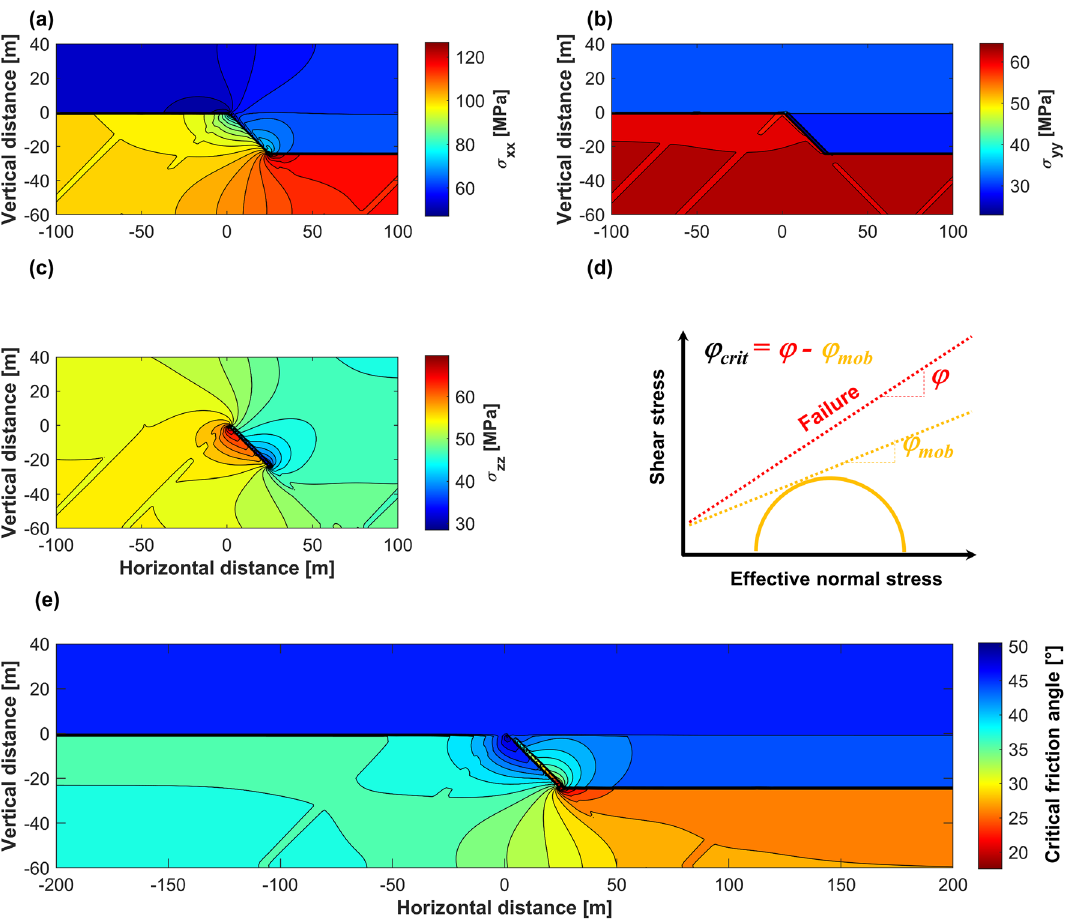
Figure 6. Stress state in the vicinity of the contact surface between competent and compliant layers. Contour lines of ( a ) horizontal in-plane total stress— σ xx , ( b ) horizontal out-of-plane total stress— σ yy , and ( c ) vertical total stress— σ zz . ( d ) Calculation of mobilized friction. ( e ) Proximity to failure in terms of the critical friction angle φ crit (difference between the friction angle φ and mobilized friction angle φ mob